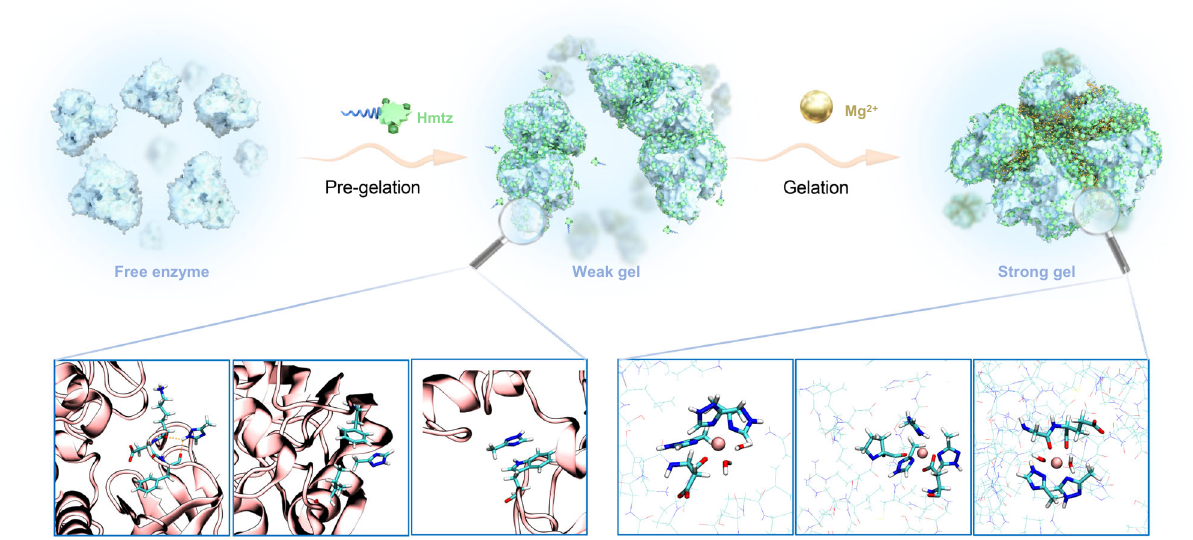
Fig. 1| SchematicofEAGpreparation. 1H-3-methyl-1,2,4-triazole (Hmtz)and Mg 2+ ions were added to the enzyme solution before the pre-gelation and gelation processes, respectively. The left three local structures show some potential